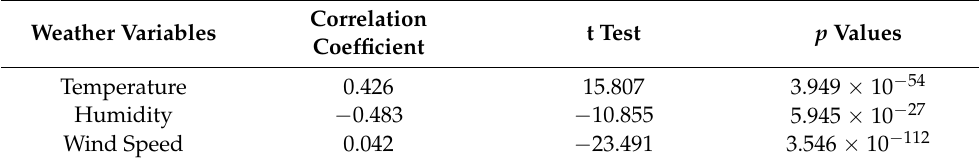
Table 3. The statistical test between weather variables and PV power output. Weather